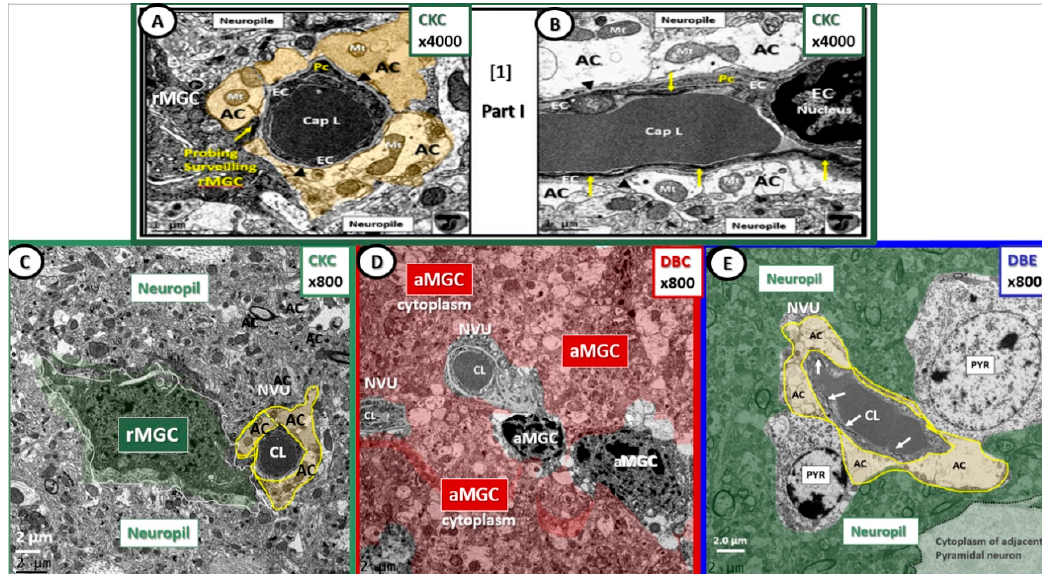
Figure 1. The neurovascular unit (NVU) in lean control (panels ( A – C ): CKC), untreated diabetic (panel ( D ): DBC), and diabetic mice treated with empagliflozin (EMPA) (panel ( E ): DBE). Panels ( A ) and ( B ) illustrate the normal ultrastructural morphology of the (NVU) in control CKC at higher magnification in order to demonstrate with greater clarity the contents of each cell comprising the NVU. Magnification 4000 × ; scale bar = 1 µ m. Modified with permission from Reference [1]. Panel ( C ) illustrates a probing ramified microglia cell (rMGC) (pseudo-colored green) probing the NVU with an intact (pseudo-colored golden) halo or corona of astrocytes (ACs) within the confines of the neuropil. Panel ( D ) depicts an invasive (pseudo-colored red) activated microglia cell (aMGC) that has completely engulfed the NVU (uncolored) with markedly thickened basement membranes in DBC. Also, note the increased electron density and volume of chromatin within the aMGC nuclei in this image in addition to the detachment and retraction of ACs of the NVU. It is also important to note that there is a loss of pericytes and the normal intact ACs to form the halo—corona as in CKC and DBE (panels ( C ) and ( E )). Panel ( E ) depicts an intact NVU, which is in close contact to two adjacent pyramidal (Pry) neurons in DBE and note the intact (pseudo-colored golden) AC halo—corona enveloping the endothelial cells similar to CKC controls with intact tight and adherens junctions within the endothelial cells (ECs) (arrows). Magnification 800 × ; scale bar = 2 µ m (panels ( C – E )). Figure images throughout text are color-coded with control CKC images outlined in green; diabetic db / db DBC in red; EMPA (SGLT2 inhibitor) treated DBE in blue in order to readily assist the reader in identification of each cohort. Cap = capillary; CL = capillary lumen.